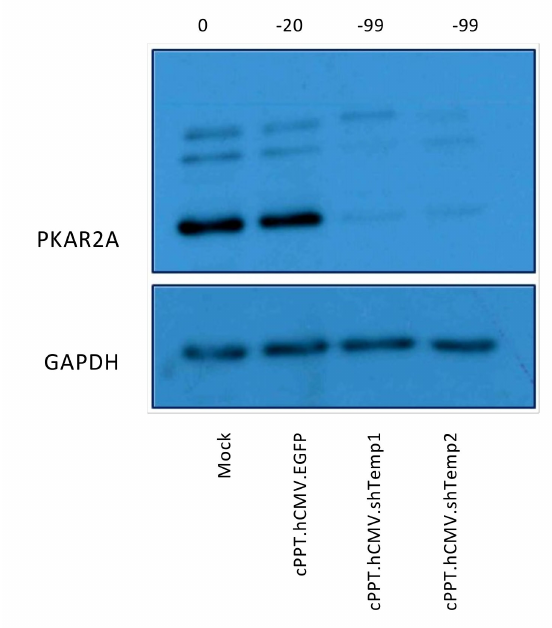
Figure 6. Recombinant lentiviral particles lead to efficient silencing of PKA R2A in primary GBM stem-like cells. Western blot analysis of primary cells transduced with equivalent RT units of recombinant lentiviral particles analyzed three months post-transduction. Bands were quantified, the percentage of reduction is indicated above each lane and was calculated relative to mock-infected cells. Primary antibodies: PKA R2A and GAPDH; secondary antibody: anti-rabbit